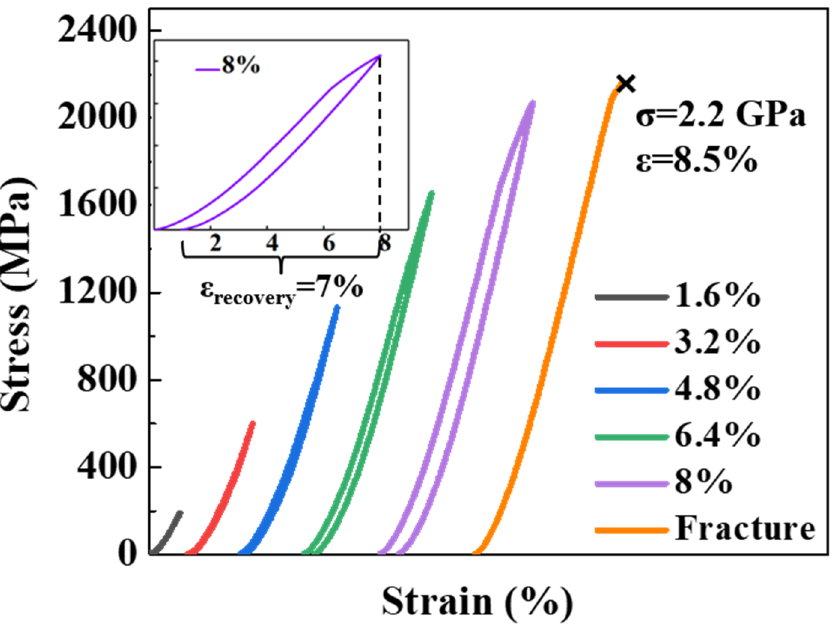
Figure 6. Compressive loading-unloading curves of the well-established SLM 60NiTi fabricated by P = 80 W and v = 350 mm/s.